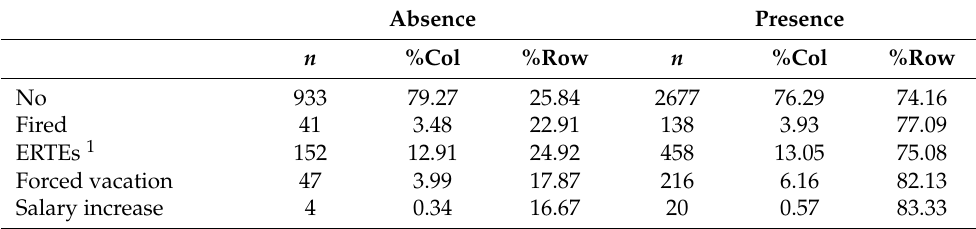
Table 3. “Have you undergone a contractual change?” is also associated with state